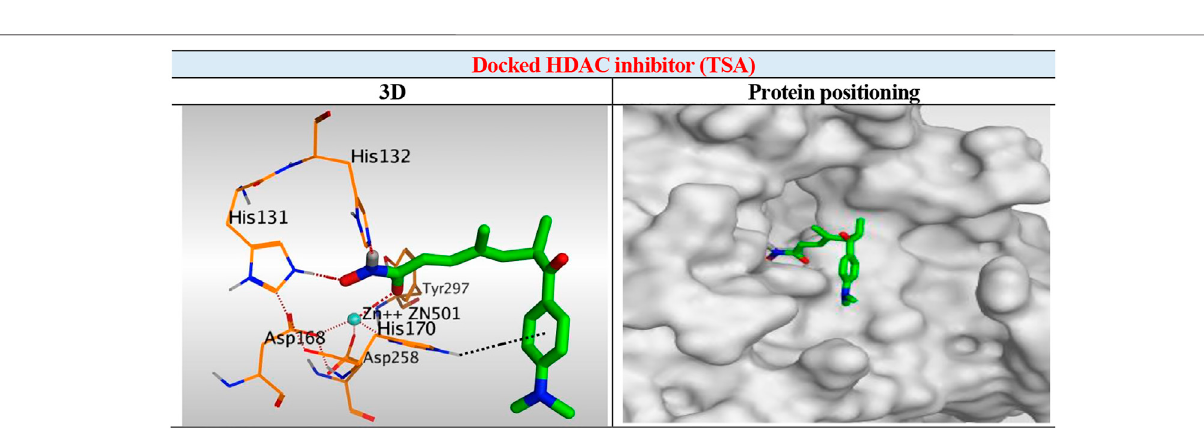
FIGURE 7 | 3D representation and positioning for the docked TSA inside the tubular pocket of the HDAC receptor.